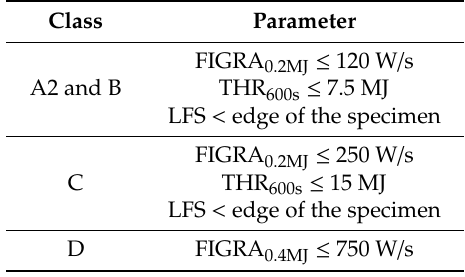
Table 4. Threshold values for SBI test in the euroclasses system